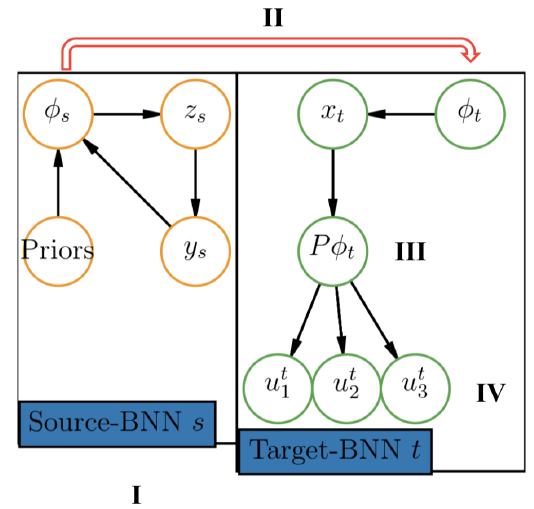
Figure 1. Uncertainty Flow Framework. The graphic model explanation of our proposed Uncertainty Flow framework shows four essential elements. I.e., the dual Bayesian neural networks in I , e.g., a source and a target BNN(separate by different colours in Figure 1); the weakly informative prior in II ; the quantification of model uncertainty in III ; and three proposed uncertainty indexes in perfecting the final multi-label categorisation in IV